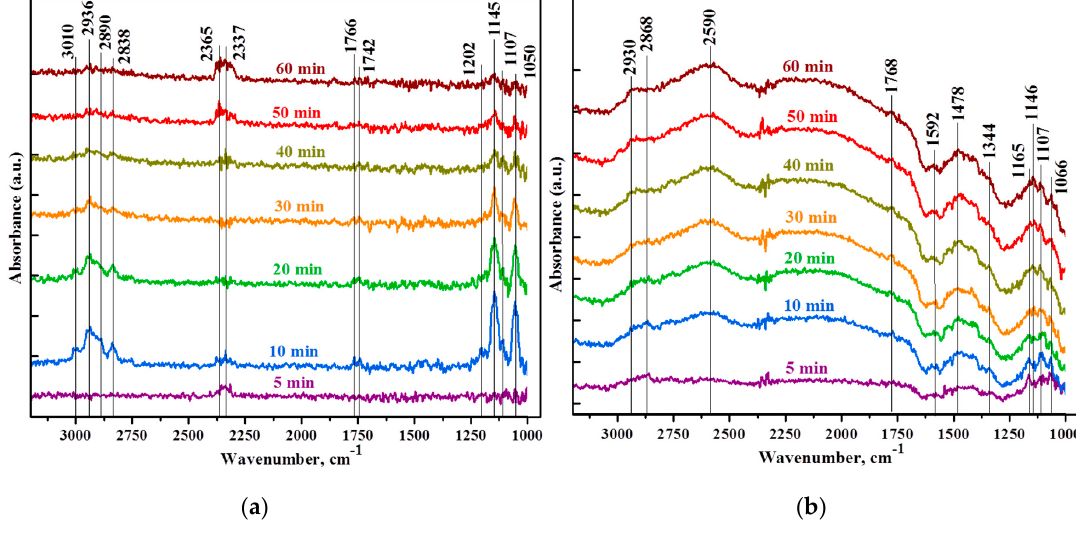
Figure 9. In situ DRIFT spectra of the unmodified SnO 2 (SnTi-0) ( a ) and SnTi-2 nanocomposite ( b ) during HCHO adsorption at room temperature.